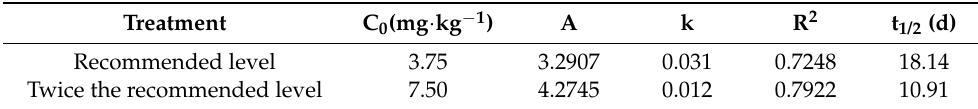
Table 1. Kinetic parameters of fomesafen degradation in soil applied at the recommended level and twice the recommended